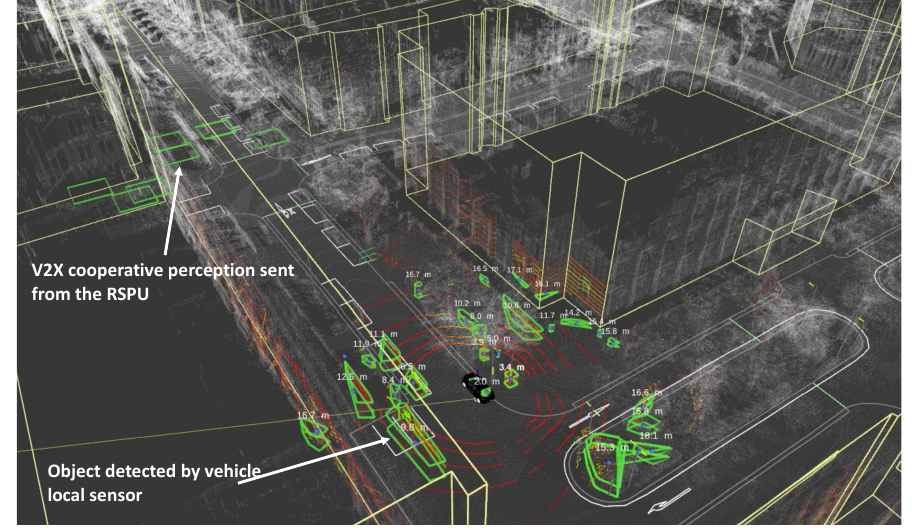
Figure 4. Screenshot of RViz with